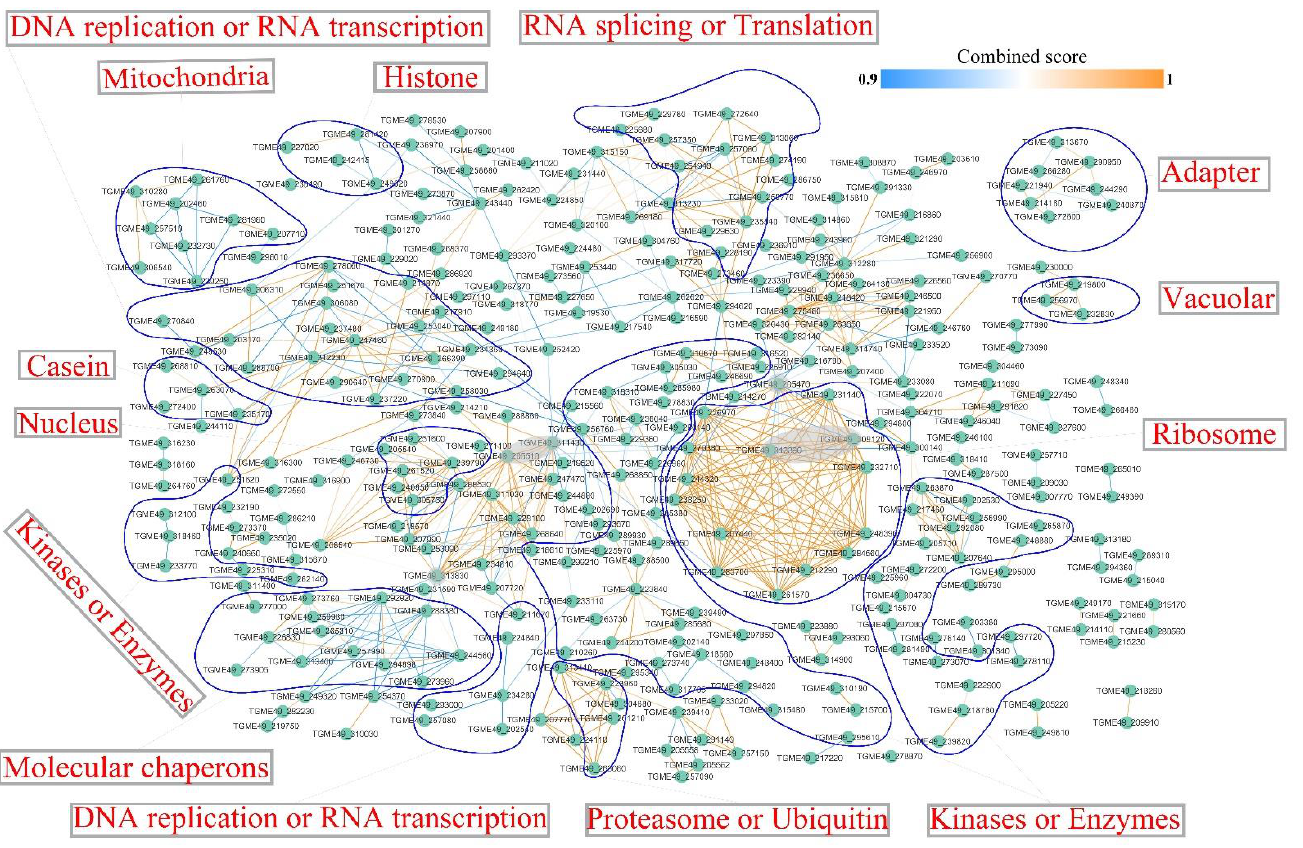
Figure 9. Protein–protein interaction (PPI, combined score ≥ 0.9) network of the DEPs between sporulated oocysts and tachyzoites. The nodes indicate DEPs and the lines between the nodes refer to the interactors between DEPs. The color of the edge symbolizes the combined score of the interacting partners.